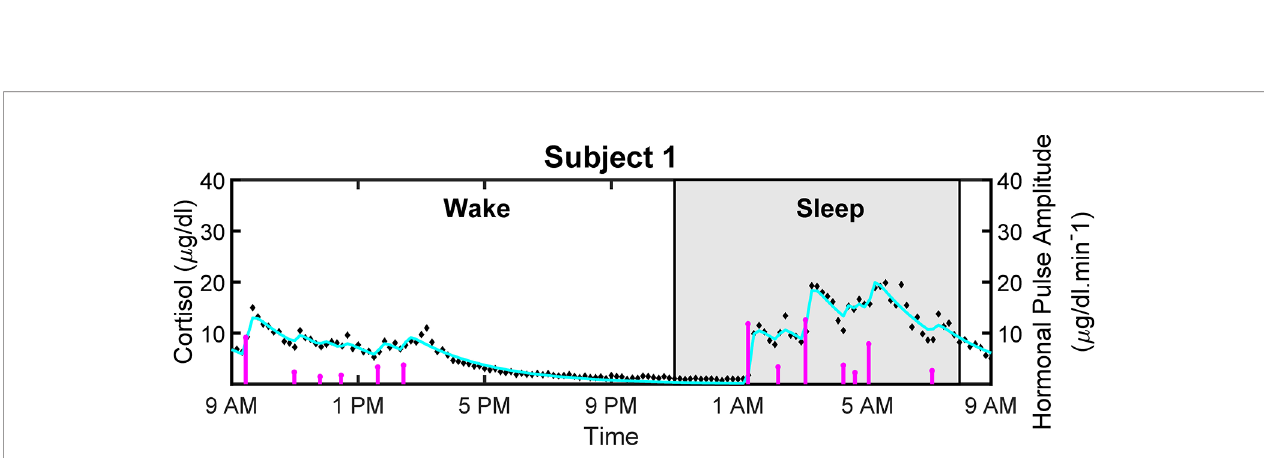
FIGURE 4 | Deconvolved Experimental Twenty-Four Hour Cortisol Levels in Patient with Obesity. Plot shows the measured 24-hour cortisol time series (black diamonds), the reconstructed cortisol levels (cyan curve), the estimated pulse timings and amplitudes (magenta vertical lines).